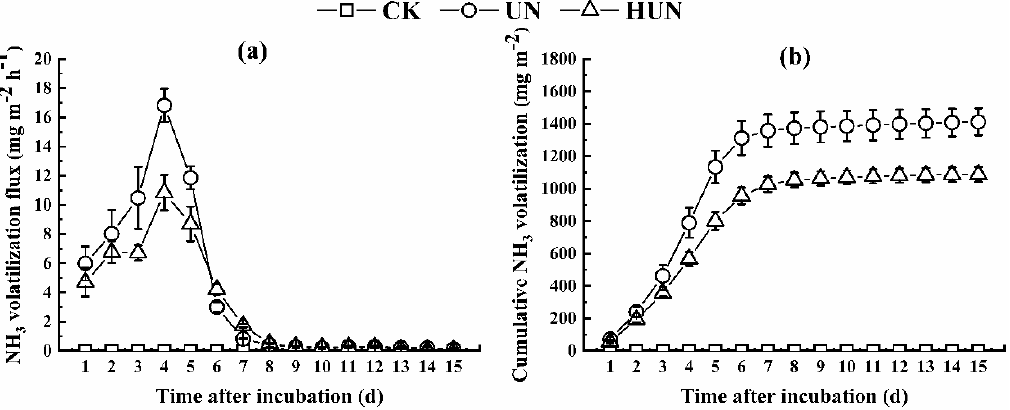
Figure 3. Effects of different treatments on NH 3 volatilization flux ( a ) and cumulative ammonia volatilization ( b ). The vertical coordinate corresponding to the point is the average value. The length of the error bars is the standard deviation. NH 3 : ammonia, CK: no nitrogen, UN: urea at 240 kg N hm − 2 , HUN: humic acid urea at 240 kg N hm − 2 .